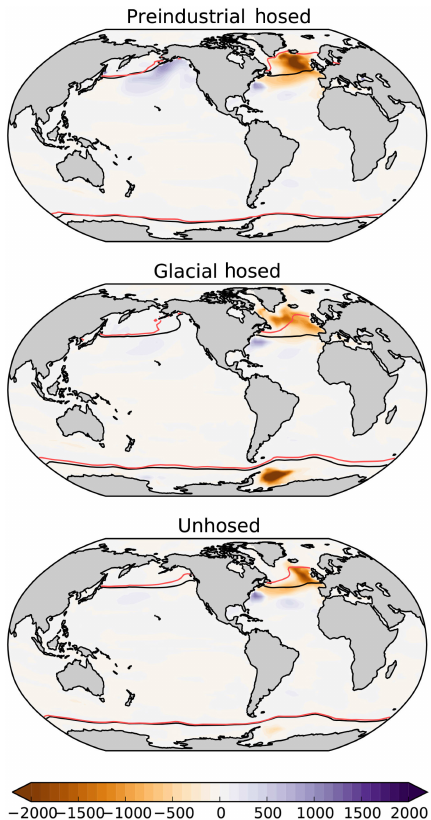
Figure 4. Stadial winter mixed-layer depth anomaly. The top two panels show the difference in winter mixed-layer depth between weak and strong AMOC states (as defined in Fig. 3) under prein- dustrial and glacial boundary conditions, averaged between the four sets of orbital configurations (see Fig. S6 to view all eight hos- ing simulations individually). The bottom panel shows the win- ter mixed-layer depth between weak and strong AMOC states (as defined in Fig. 3) in the unhosed simulation. Black and red con- tours show the sea-ice edge for the weak AMOC and strong AMOC states, respectively. Sea-ice edge is defined as >30% of annually averaged ice concentration. Shading in